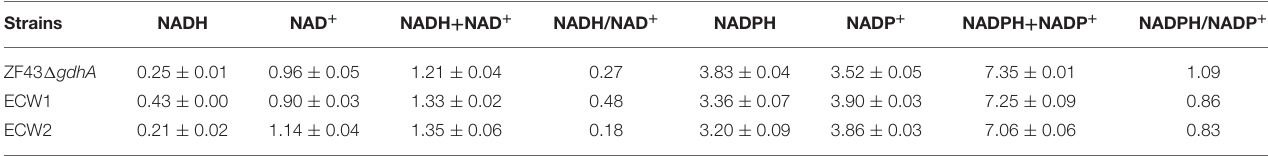
TABLE 2 | Specific intracellular concentrations ( µ mol/g DCW) of NADH and NADPH in Escherichia coli strains ZF43 1 gdhA , ECW1, and ECW2 at 12h of fermentation. Strains NADH NAD + NADH + NAD + NADH/NAD + NADPH NADP + NADPH + NADP + NADPH/NADP + ZF43 1